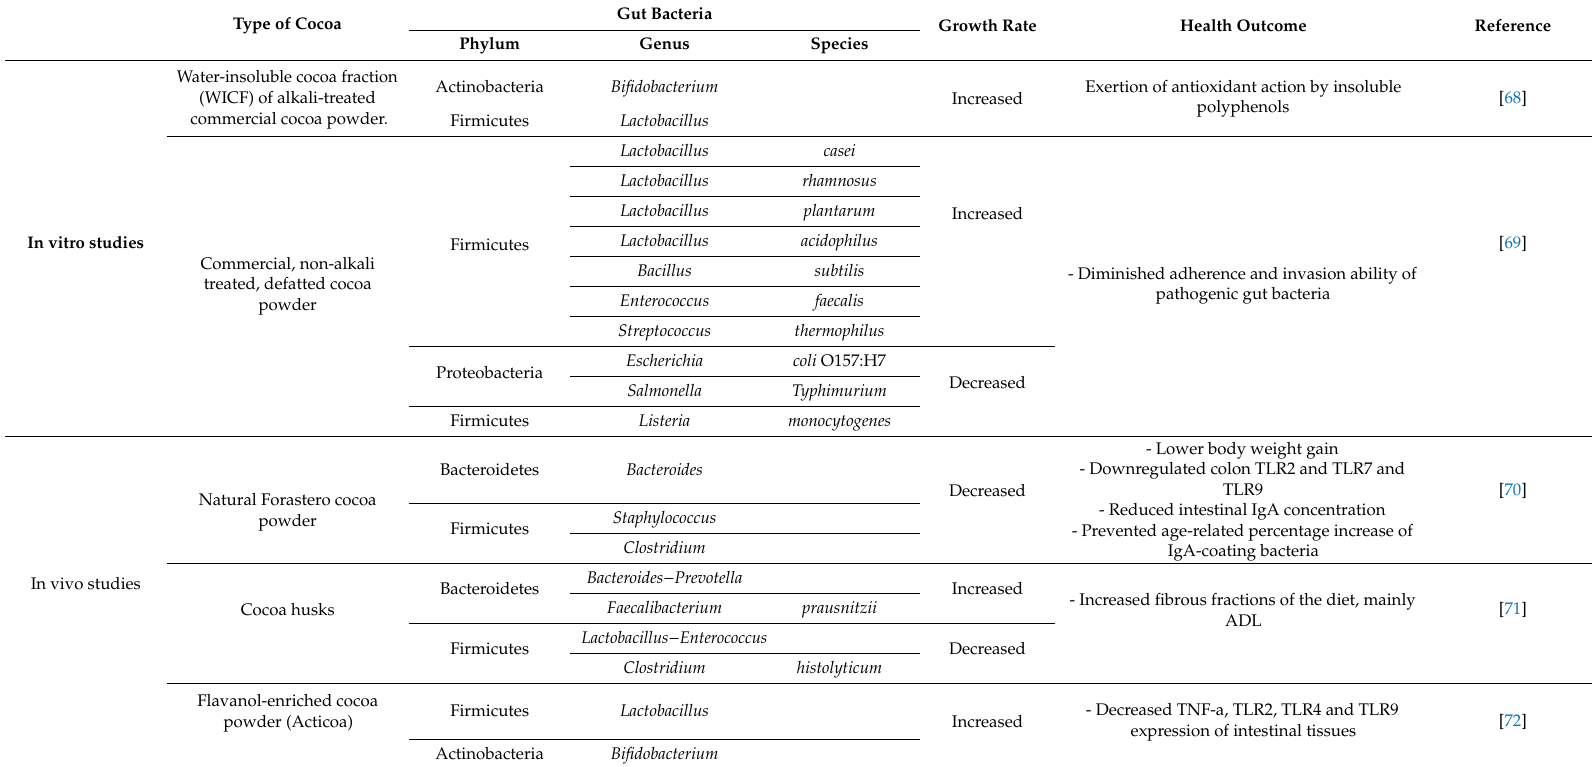
Table 3. The e ff ect of cocoa and its derivatives on the growth of gut bacteria from in vitro, in vivo and clinical